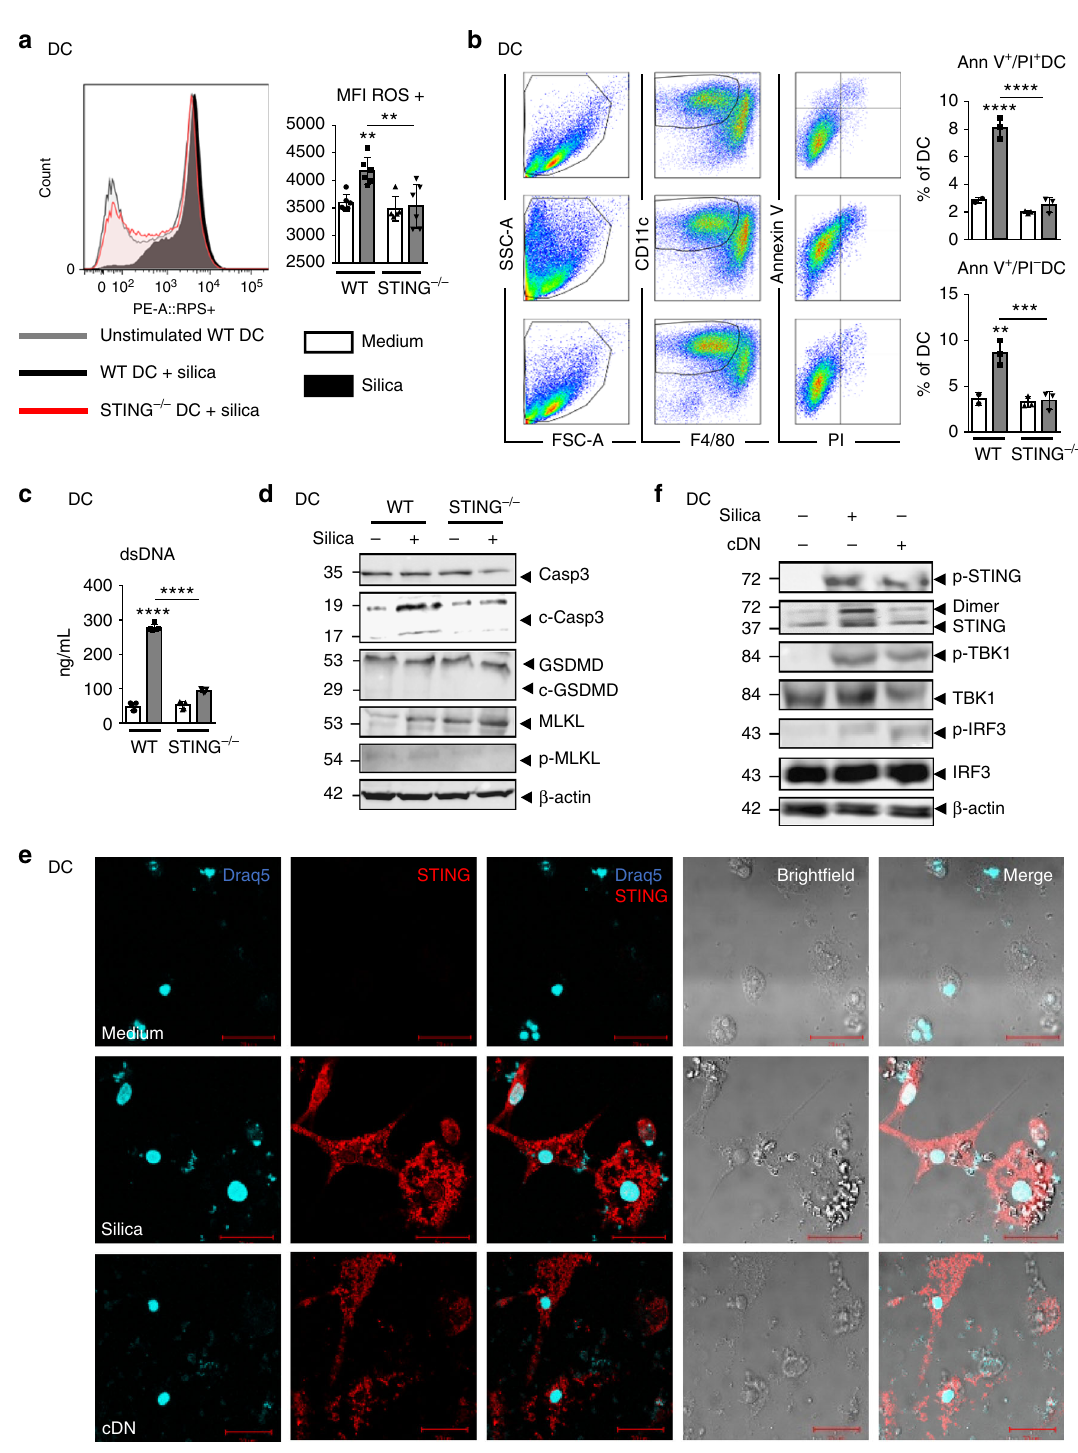
Fig. 6 Dendritic cells respond to silica by mitochondrial and cellular stress associated with dsDNA leakage and STING activation. a , b WT and STING − / − bone marrow-derived DCs were unstimulated or stimulated with silica (250 µ g/mL) for 18h. a Flow cytometry using MitoSOX staining of mitochondria- derived superoxide production on pre-gated singlet cells (SSC-A/SSC-H) and CD11b + CD11c + F4/80 – DCs. Histograms and mean fl uorescence intensity (MFI) quanti fi cation. b Flow cytometry Annexin V/PI staining showing early apoptotic (Ann V + /PI − ) versus late apoptotic/necrotic (Ann V + /PI + ) DCs. c Concentration of extracellular dsDNA in culture supernatant. d Immunoblots of caspase 3, cleaved caspase 3, gasdermin D, MLKL, and phospho-MLKL in WT and STING − / − DCs with β -actin as a reference. e Confocal images of DNA dye Draq5 (cyan) and STING-speci fi c antibody (red) in WT DCs stimulated